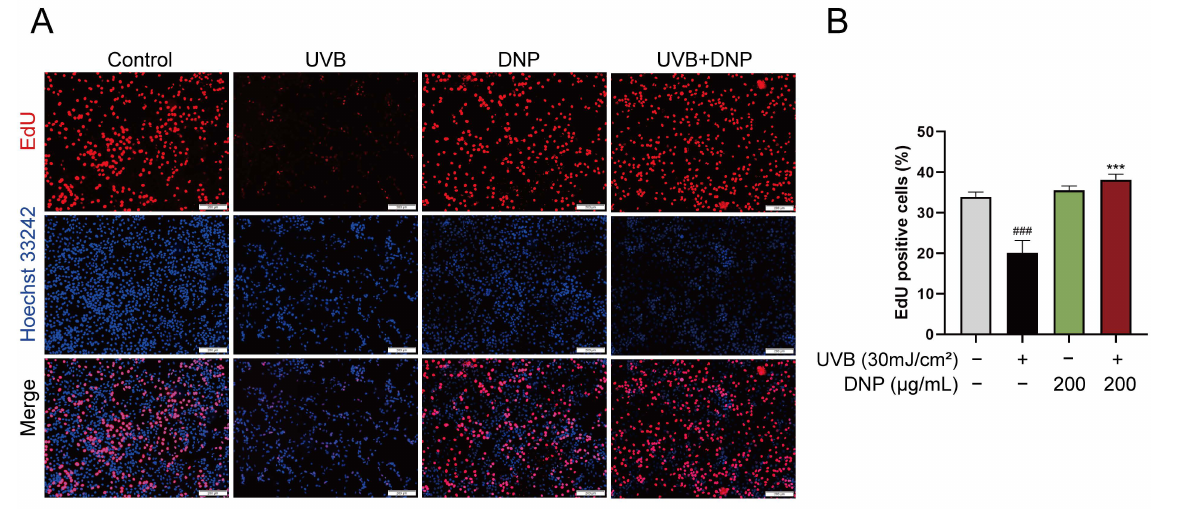
Figure 6. DNPs promote HaCaT cell proliferation. ( A ) Representative images of EdU staining. Proliferating cells are stained red, and cell nuclei are stained blue. Scale bar = 200 µ m. ( B ) Statistical analysis of EdU-positive cells. ### p < 0.001 vs. control group; *** p < 0.001 vs. UVB group. UVB-induced oxidative stress has been reported to cause cell death via apoptosis. To determine the effect of DNP pre-treatment on UVB-induced cell apoptosis, we stained the cell nuclei with Hoechst 33258 fluorescent dye and assessed the formation of apoptotic bodies, typical morphological markers of apoptosis. Hoechst 33258 specifically binds to DNA and can identify apoptotic nuclei with DNA breaks and condensed chromatin. Compared with the controls, condensed chromatin, shrunk cells, and apoptotic vesicles were observed in UVB-irradiated HaCaT cells (Figure 7). However, pre-treatment with DNP before UVB irradiation significantly reduced the rate of apoptosis ( p < 0.05).